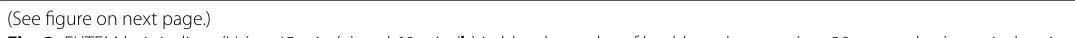
30; green dots), surgical patients ( n 30; = =